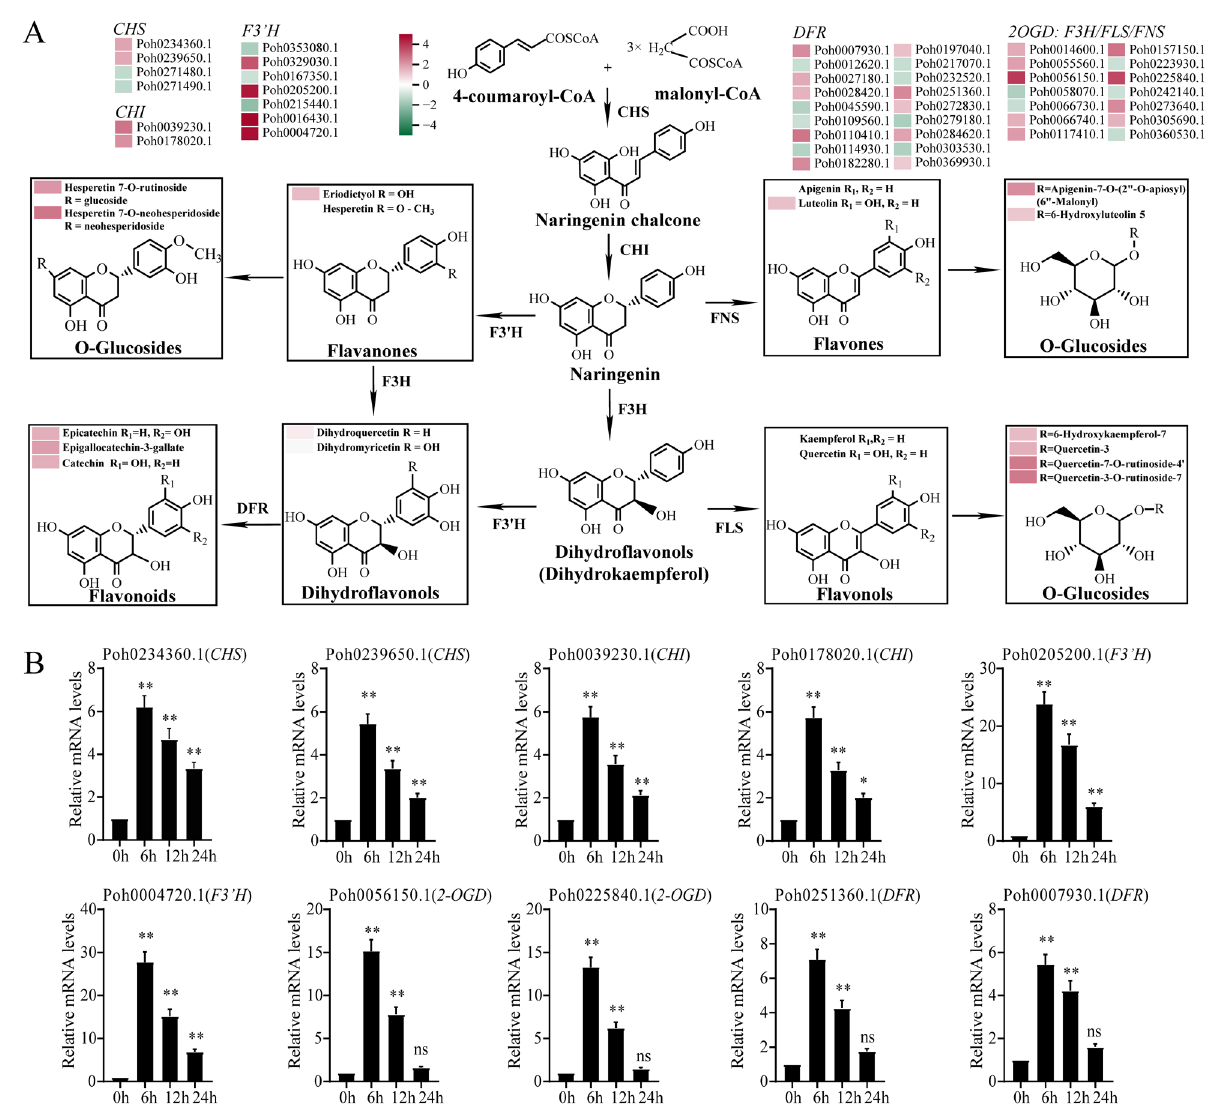
Figure 7. Integrated multi-omics analysis reveals the role of flavonoid pathway under OPDA treatment. ( A ) Proposed biosynthetic pathway of flavonoid synthesis in Pohlia nutans with heatmap showing gene expression levels. The color box of each gene indicates the log 2 (fold change) obtained from transcriptome sequencing analysis. CHS , chalcone synthase; CHI , chalcone isomerase; F3H , flavanone 3-hydroxylase; FLS , flavonol synthase; FNS , flavone synthase; 2-OGD , 2-oxoglutarate/Fe(II)-dependent dioxygenase; F3′5′H , flavonoid 3′ -hydroxylase; DFR , dihydroflavonol 4-reductase. ( B ) qPCR analysis confirmed that several genes involved in flavonoid biosynthesis were markedly upregulated under OPDA treatment. Significant difference (* p < 0.05, ** p < 0.01, ns, no significant).